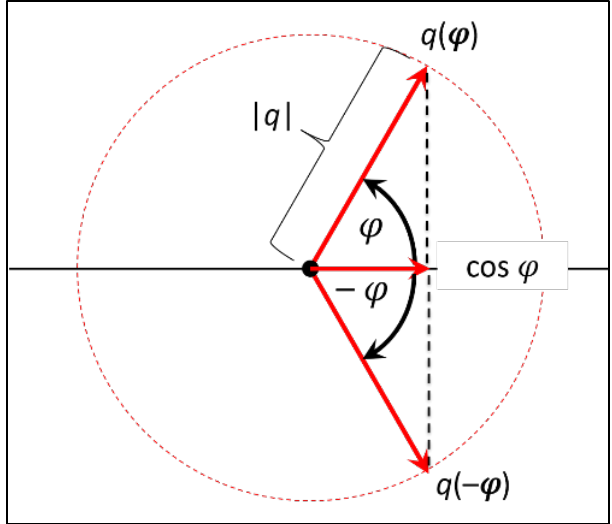
Figure A2. Phasor representation of an oscillating field.